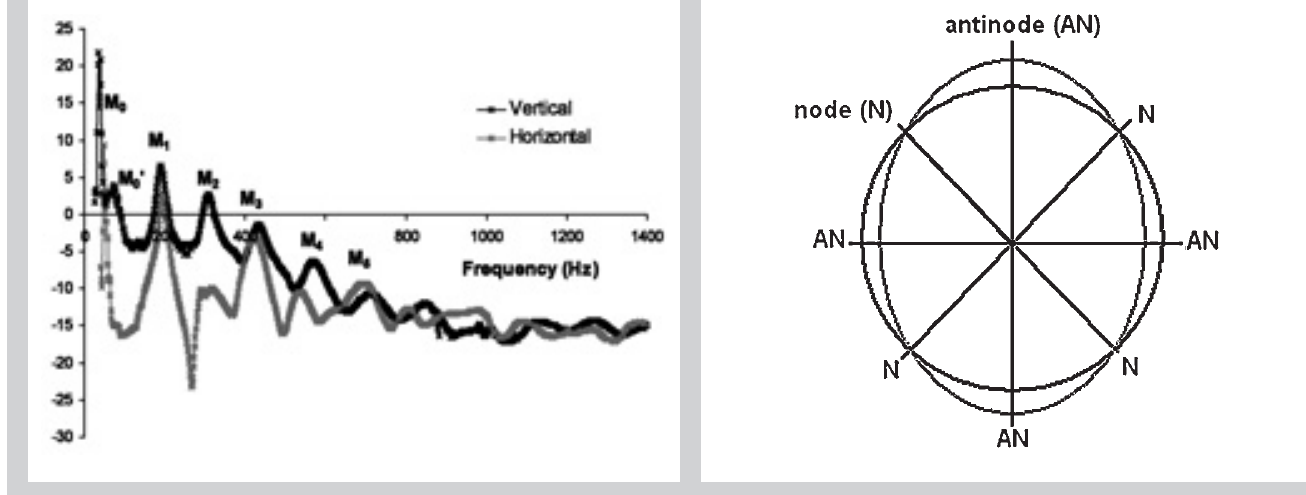
Figure 2 (left): Examples of AFPs (ampli- tude versus frequency plot) obtained for melon in stage of ripening (mass 2.09 kg, mean diameter 15.8 cm). The LDV analysis in vertical position of laser (Vertical) and horizontal position of laser (Horizontal) was per- formed at the same place at the “equatorial” plane of the melon, but location of the forcing at the plane was shifted ~90˚around the – M axis. The marks M 0 5 denote spheroidal modes of vibration (see Table 1). Figure 3: Plot of the main cross sec- tion of a spherical product vibrating in the spheroidal mode M . The black line 1 determines the basic spheri- cal shape of the product; the red line expresses one of the positions of the vibrating surface. The yellow colour shows change of the prod- uct shape due to vibration: the increase of the product radius in vertical direction and its decrease in horizon- tal direction. The location of the nodal lines (nodes – N) and the antinodes (AN) is also denoted. Two neigh- bour antinode segments with the opposite deviations from the original spherical shape form one period. In our case there are two peri- ods on the main cross sec- tion of the sphere (n = 2). Table 1: Overview of the spehroidal modes, including